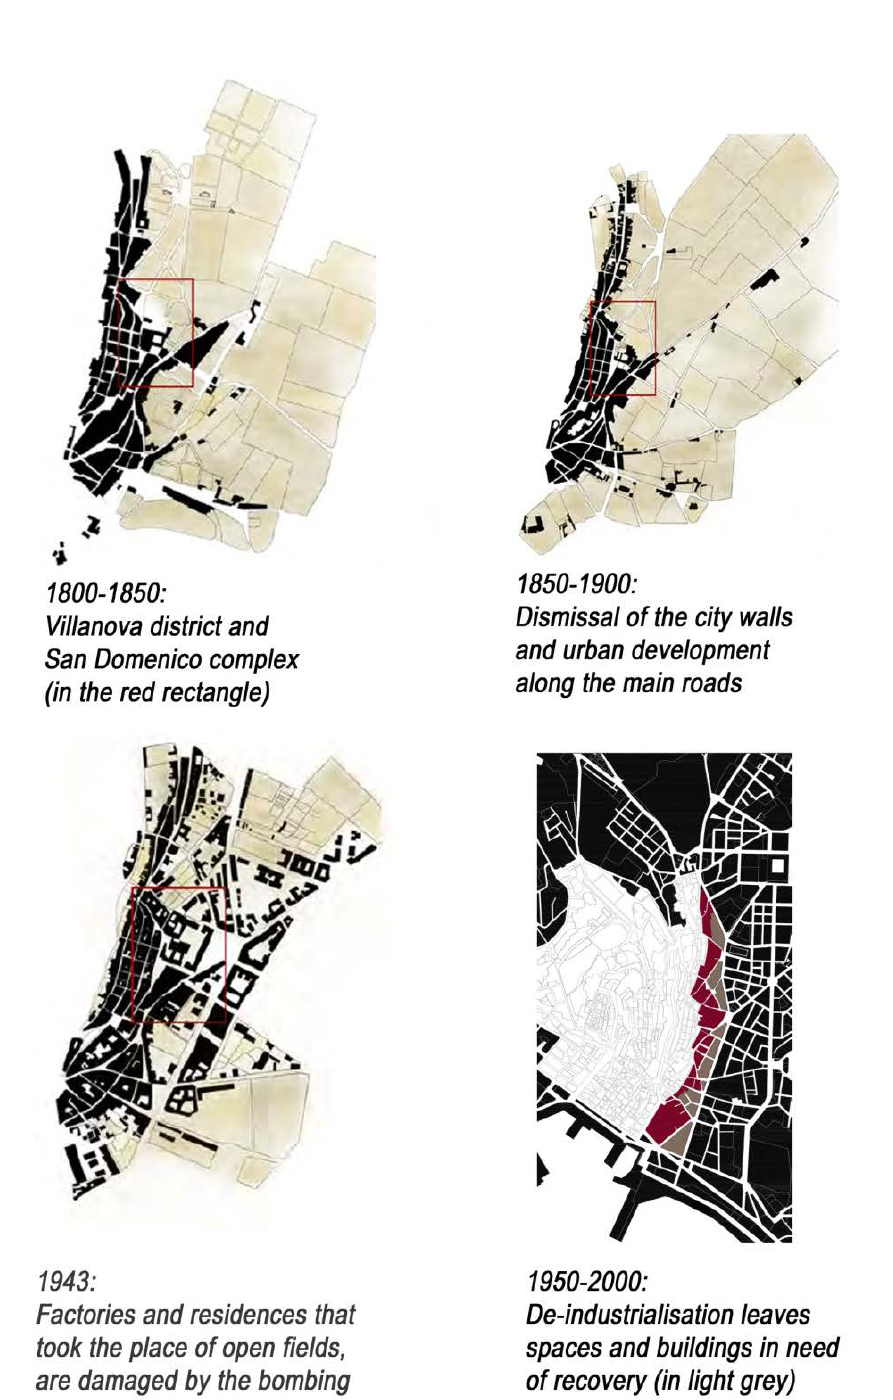
Figure 2: Evolution of Villanova District in the last two centuries Source: Elaboration of the author on the Detailed Plan for the City Centre (Cagliari